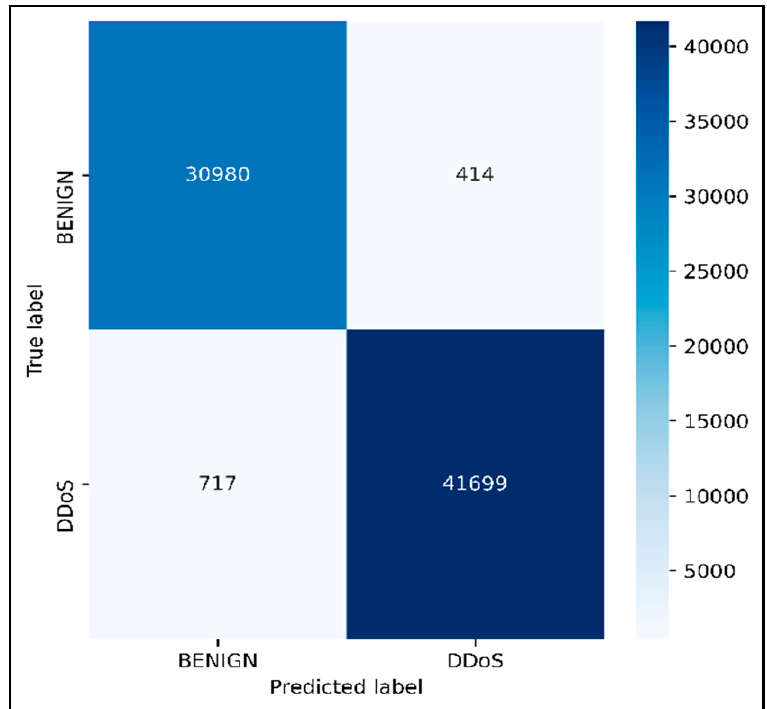
Figure 13. Friday afternoon-DDoS confusion matrix. Table 4. Statistical report of Tuesday test dataset.